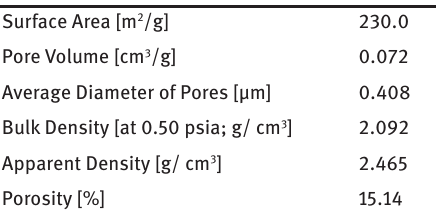
Table 2: Surface area and pore size analyses. Surface Area [m 2 /g]